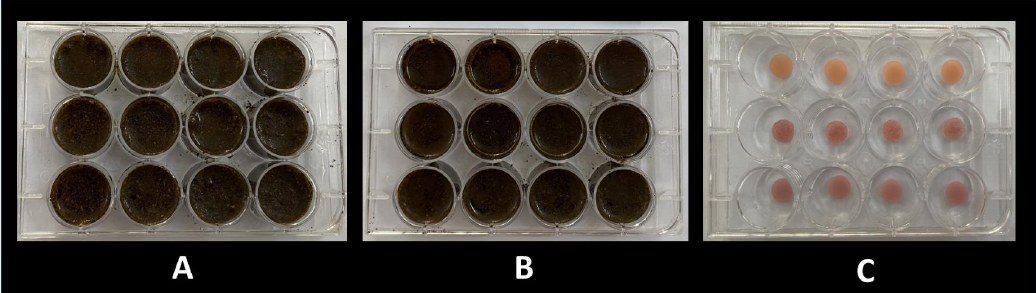
Figure 5. Specimens immersed in khaini smokeless tobacco ( A ), tabbaq smokeless tobacco ( B ), and artificial saliva ( C ).